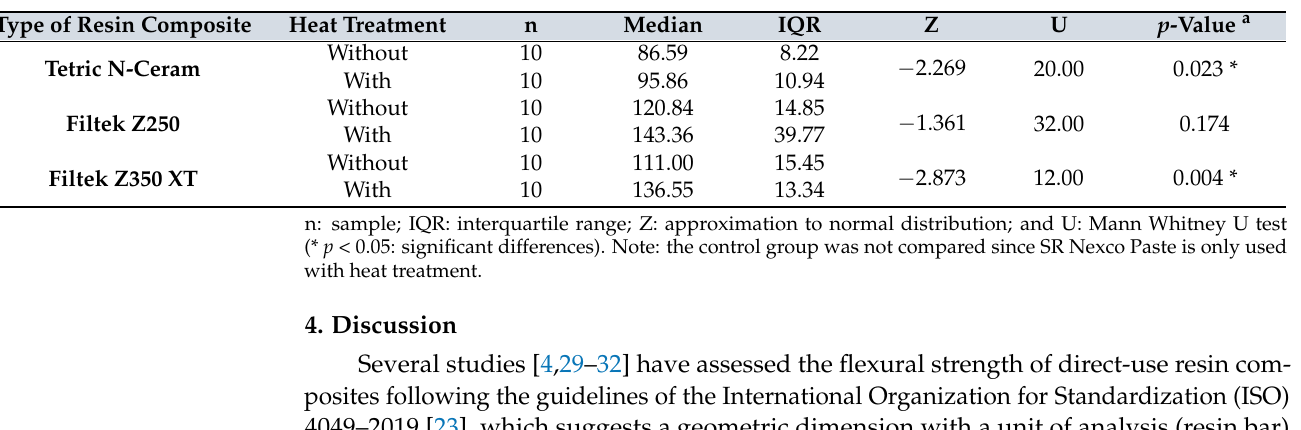
Table 6. Comparison of microflexural strength, with and without additional dry heat curing, accord- ing to the type of resin